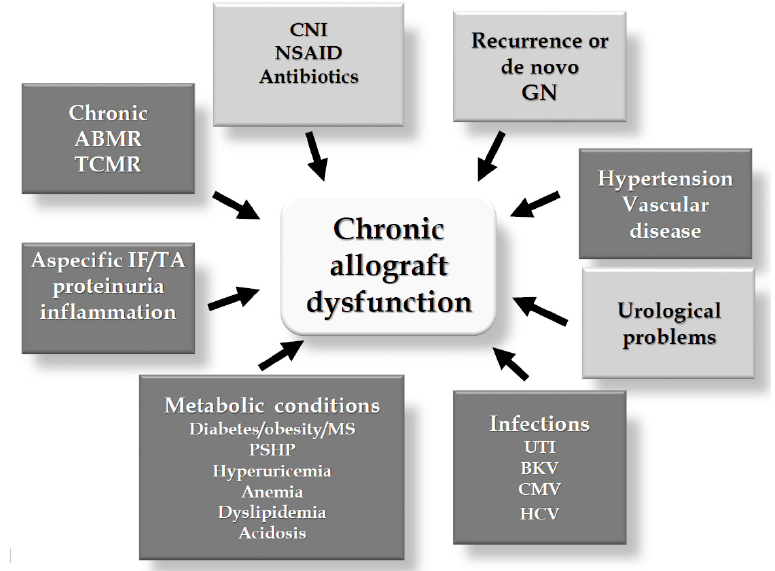
Figure 2. Main factors contributing to the development of chronic renal allograft dysfunction. The darker boxes represent mechanisms on which vitamin D status could play some counteracting role.